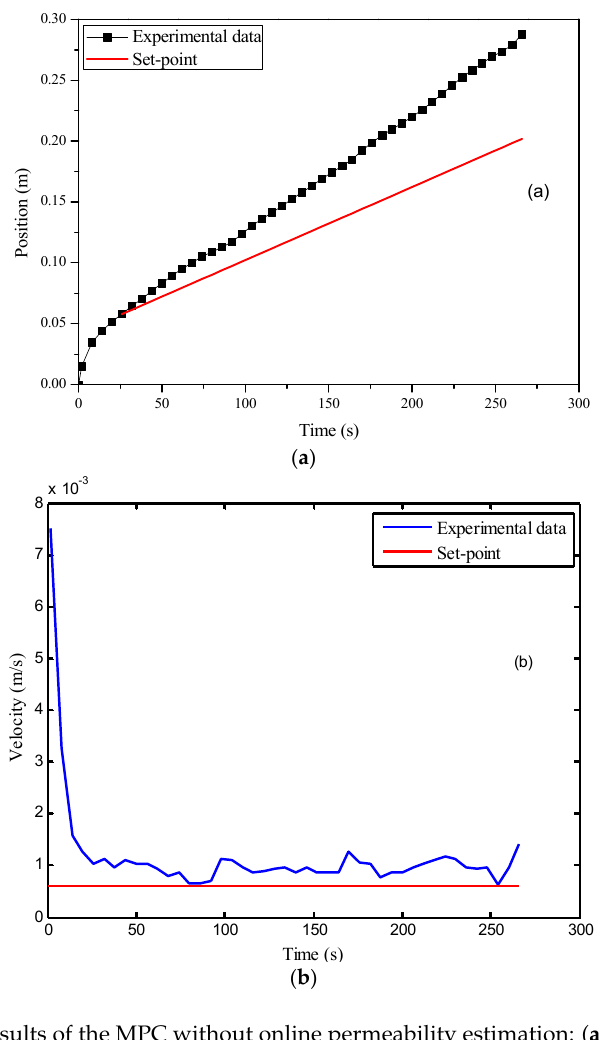
Figure 9. Control results of the MPC without online permeability estimation: ( a ) time vs. flow front position; ( b ) time vs. flow front velocity.